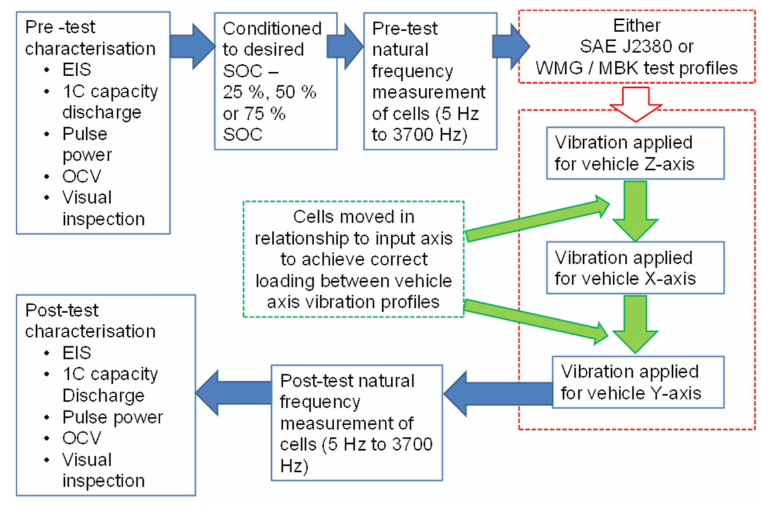
Figure 10. Schematic of test process.